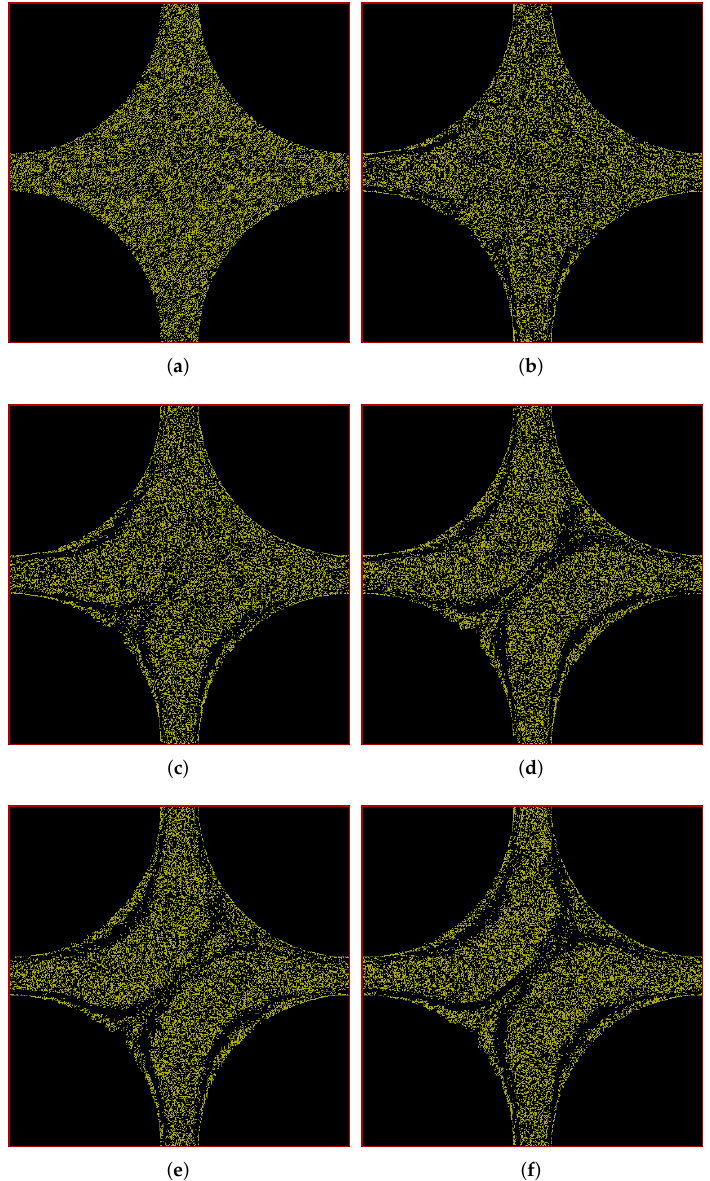
Figure 4. Snapshots of simulation (in porous-media-view) at different times showing development of polymer positions over time for flow through a cylindrical porous medium with pressure applied along the positive x - y diagonal. ( a ) t = 0 s; ( b ) t = 25 s; ( c ) t = 50 s; ( d ) t = 100 s; ( e ) t = 150 s; ( f ) t = 200